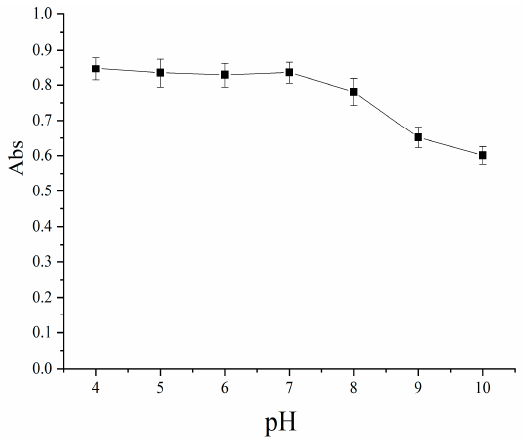
Figure 7. Absorbance curve after catalytic reaction changed with pH of the SQA-iron(II) solution.